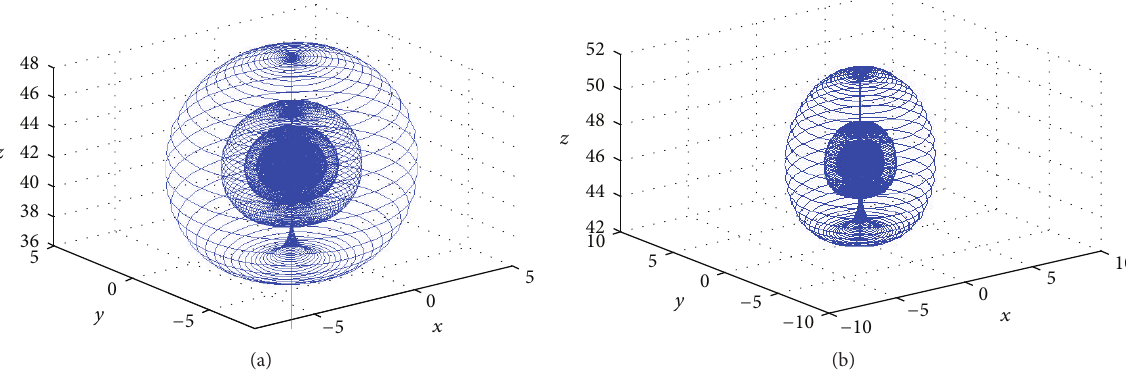
Figure 5: (a) Phase trajectory in 3D space with 𝑎 = 0.4 , 𝑏 = 3 , 𝑐 = −1.9 , 𝑞 = 0.96 , and 𝑠 = 0.001 ; (b) interior phase trajectory of